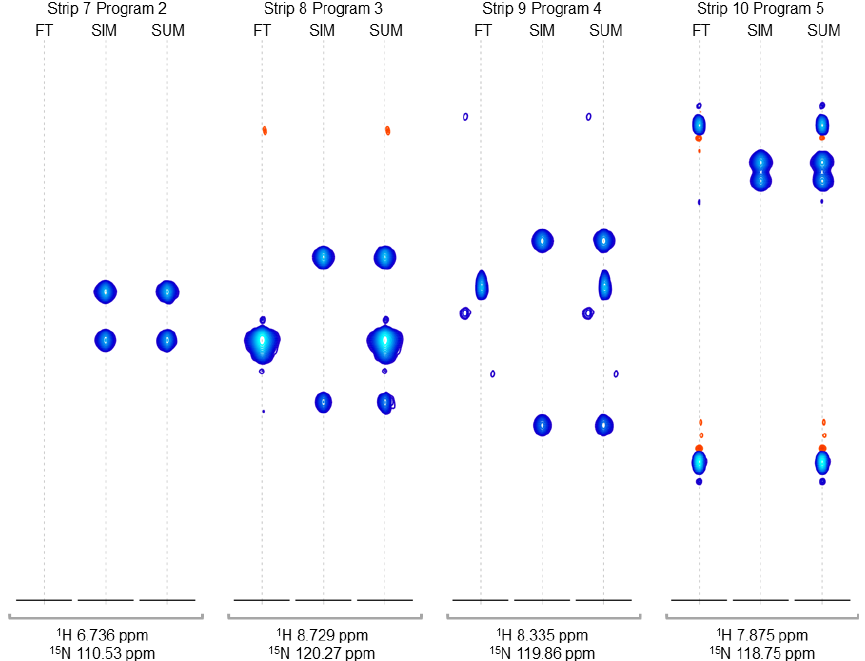
Figure 4. Strip plots of synthetic peaks. These strips show the auto-generated synthetic peaks and the corresponding measured data from the command in Fig. 3. The command uses five “programs” to produce strips of synthetic 3D signals at 10 1 H, 15 N positions. The last four groups of strips (groups 7 to 10) are shown here, from the measured spectrum, simulated spectrum, and sum, labeled FT, SIM, and SUM, respectively. For these HNCA data, two simulated signals are inserted in every case. Strip group 7 corresponds to a program which inserts signals at 1 H, 15 N locations where there are no peaks anywhere in the original data, so that the “FT” strip in group 7 shows no signals. Strip group 8 corresponds to a program that inserts non-overlapping peaks at a 1 H, 15 N position where there are signals at other 13 C positions in the original data. Strip group 9 corresponds to a program that inserts peaks which are offset by 0.5ppm in the 15 N dimension relative to an existing peak in the original data. Strip group 10 corresponds to a program which inserts two peaks that are 0.9ppm apart in the 13 C dimension. It can also be seen that the measured data for this case have a combination of peaks with a broad appearance, as in FT strip 8, and peaks with a narrow appearance, as in FT strips 9 and